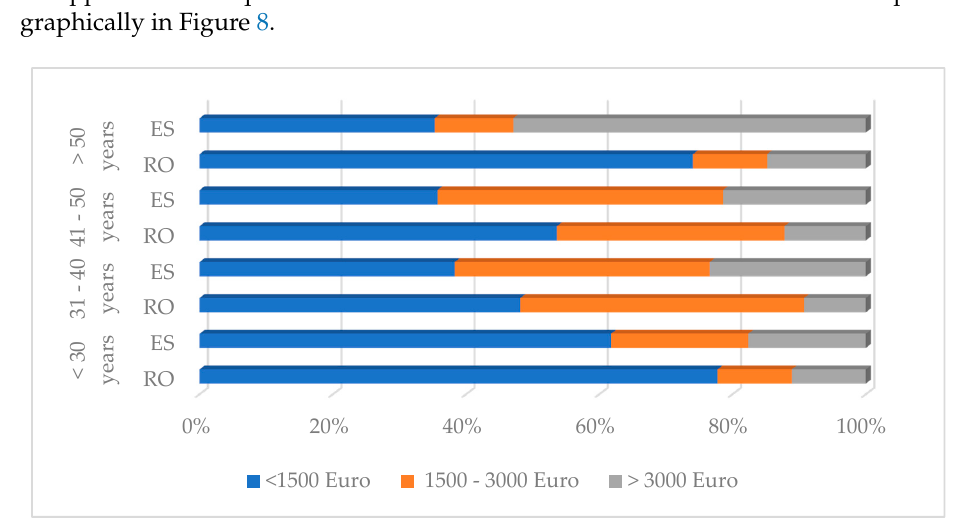
Table 5. Correlation coefficients for Spain.